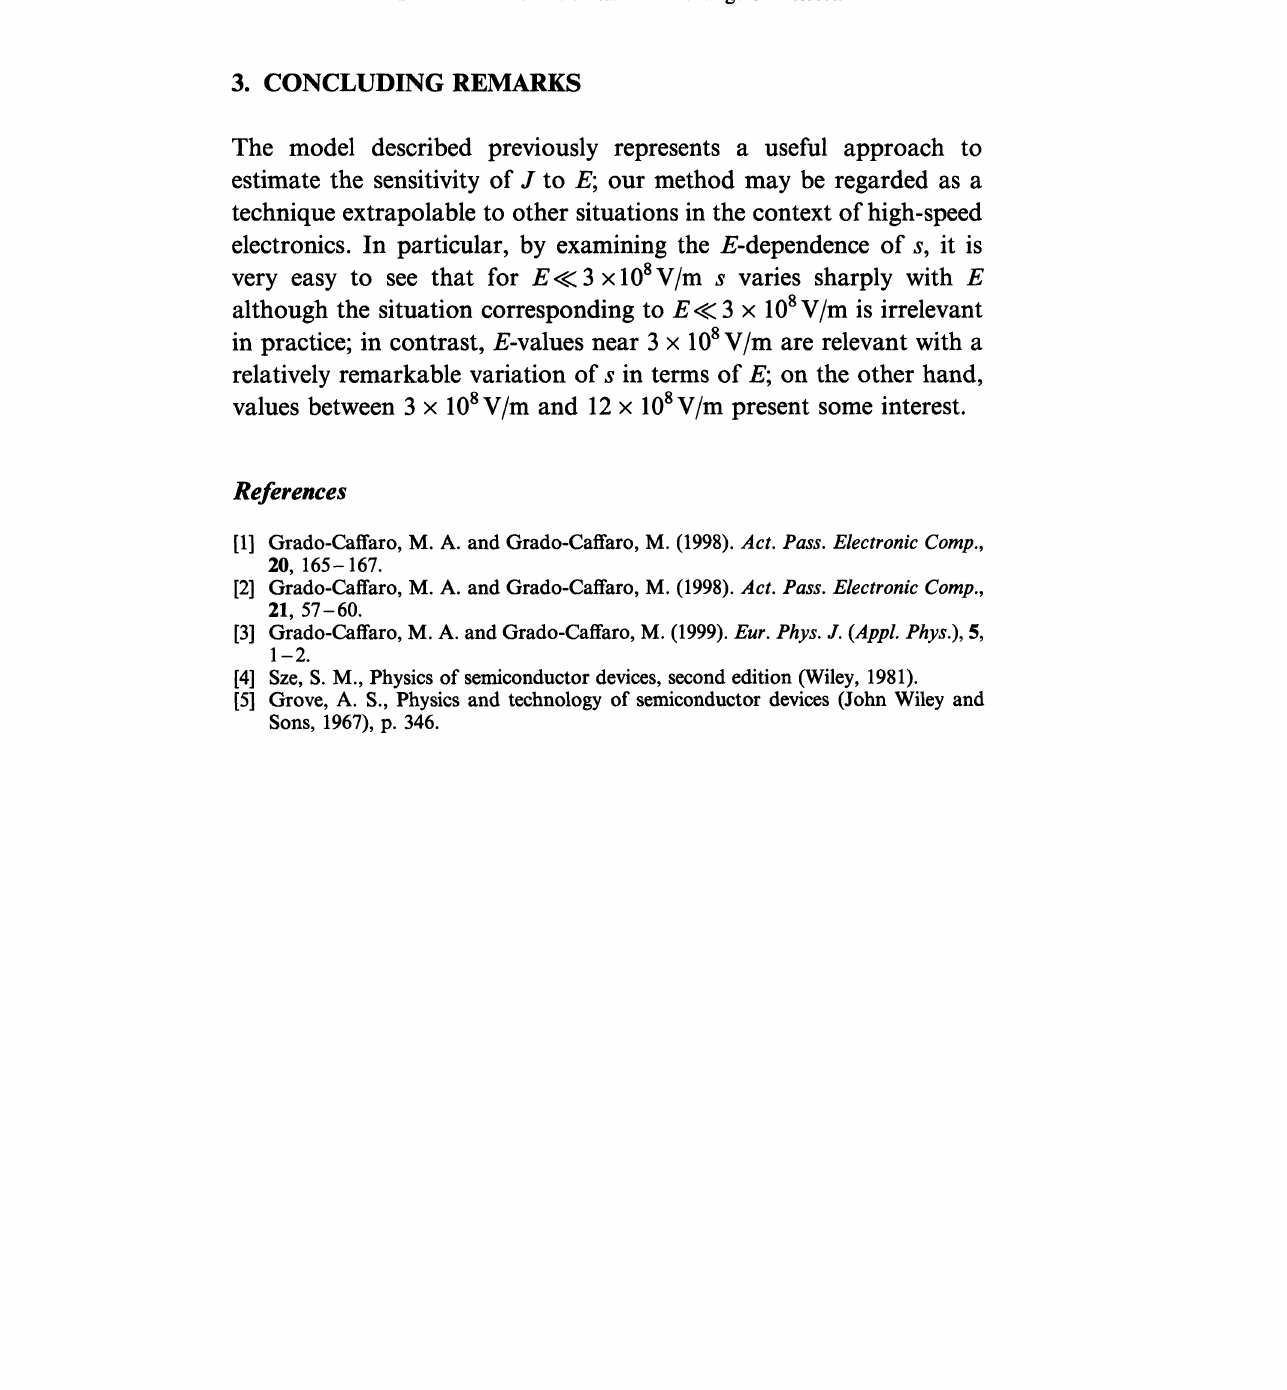
FIGURE Plot of s versus E for a range of